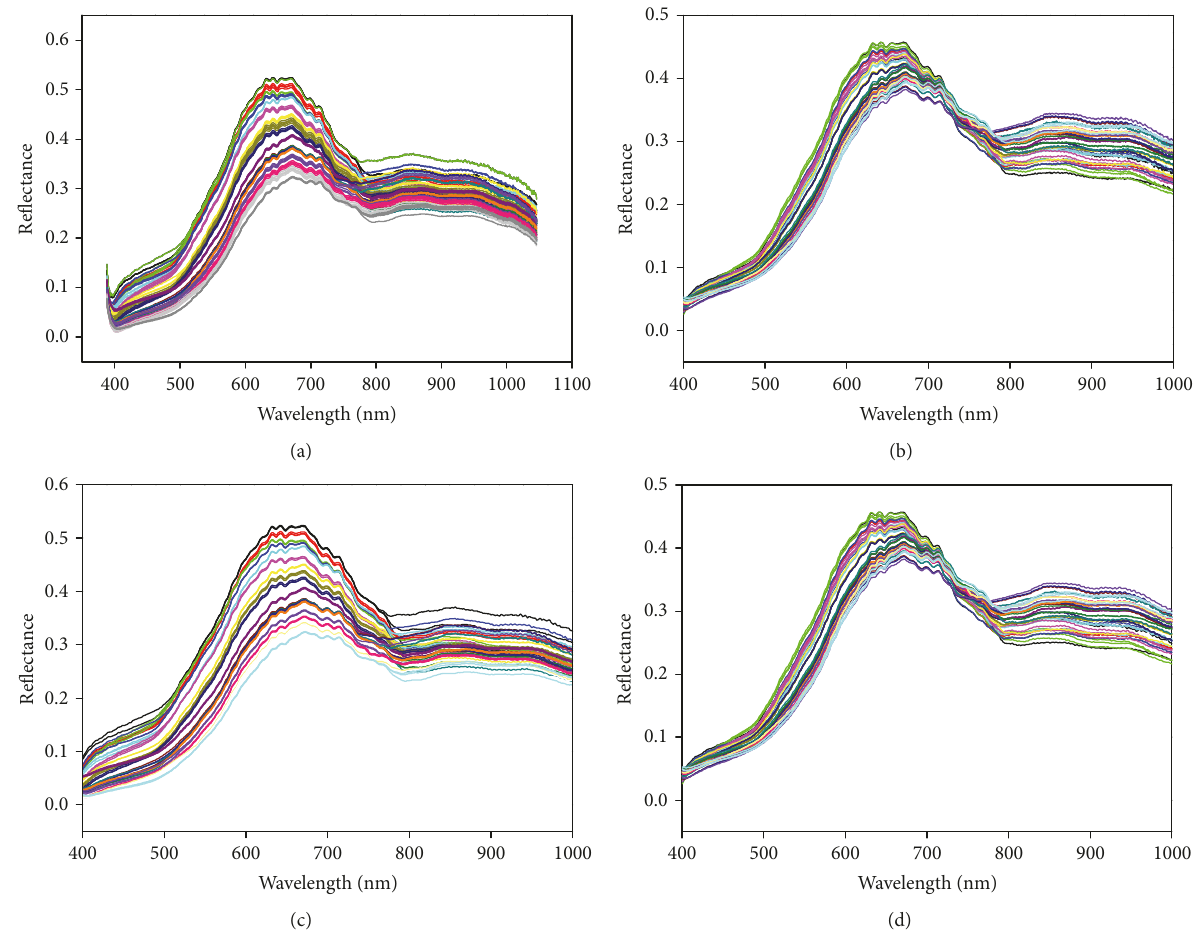
Figure 2: The original ARS (a) and pretreated ARS with MSC (b), SG (c), and MSC-SG (d).